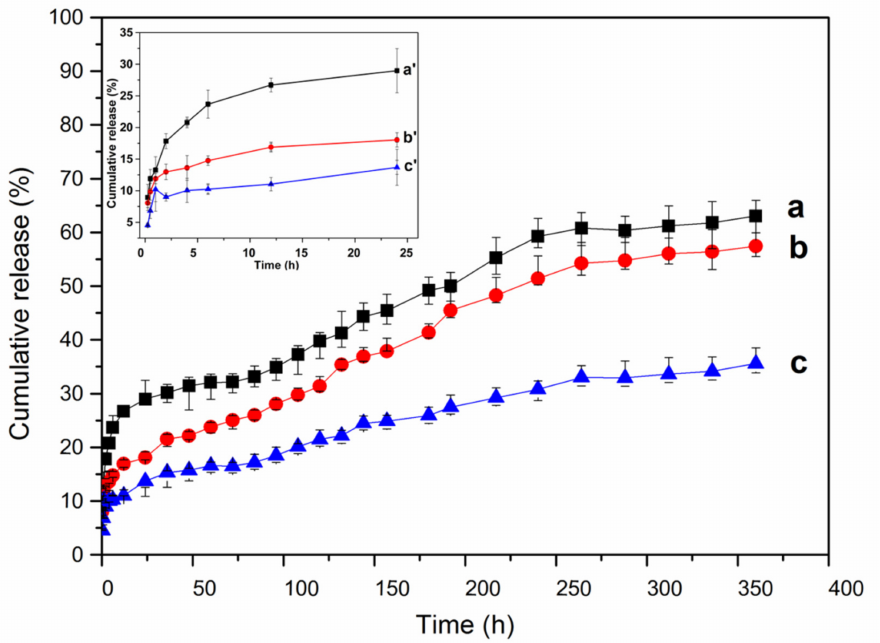
Figure 8. Cumulative release profiles of lysozyme from ( a ) lysozyme-loaded MSNTs-1, ( b ) lysozyme- loaded MSNTs-2, ( c ) lysozyme-loaded MSNTs-3. The insets ( a’ – c’ ) correspond to the cumulative release profiles of ( a – c ) in the first 24 h,